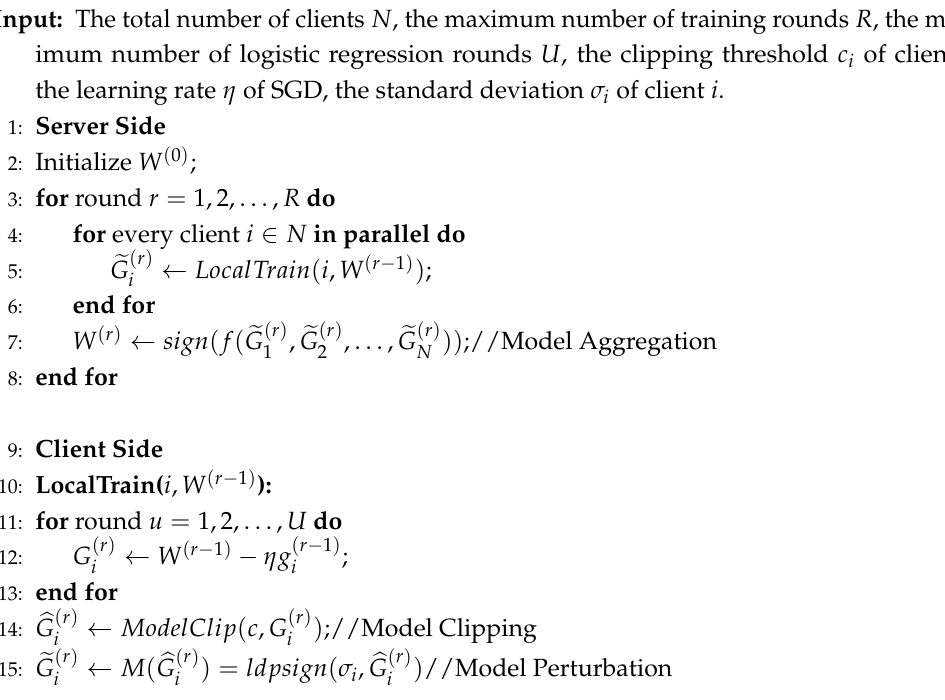
Algorithm 2 Federated learning with personalized local differential privacy on non- independent identically distributed